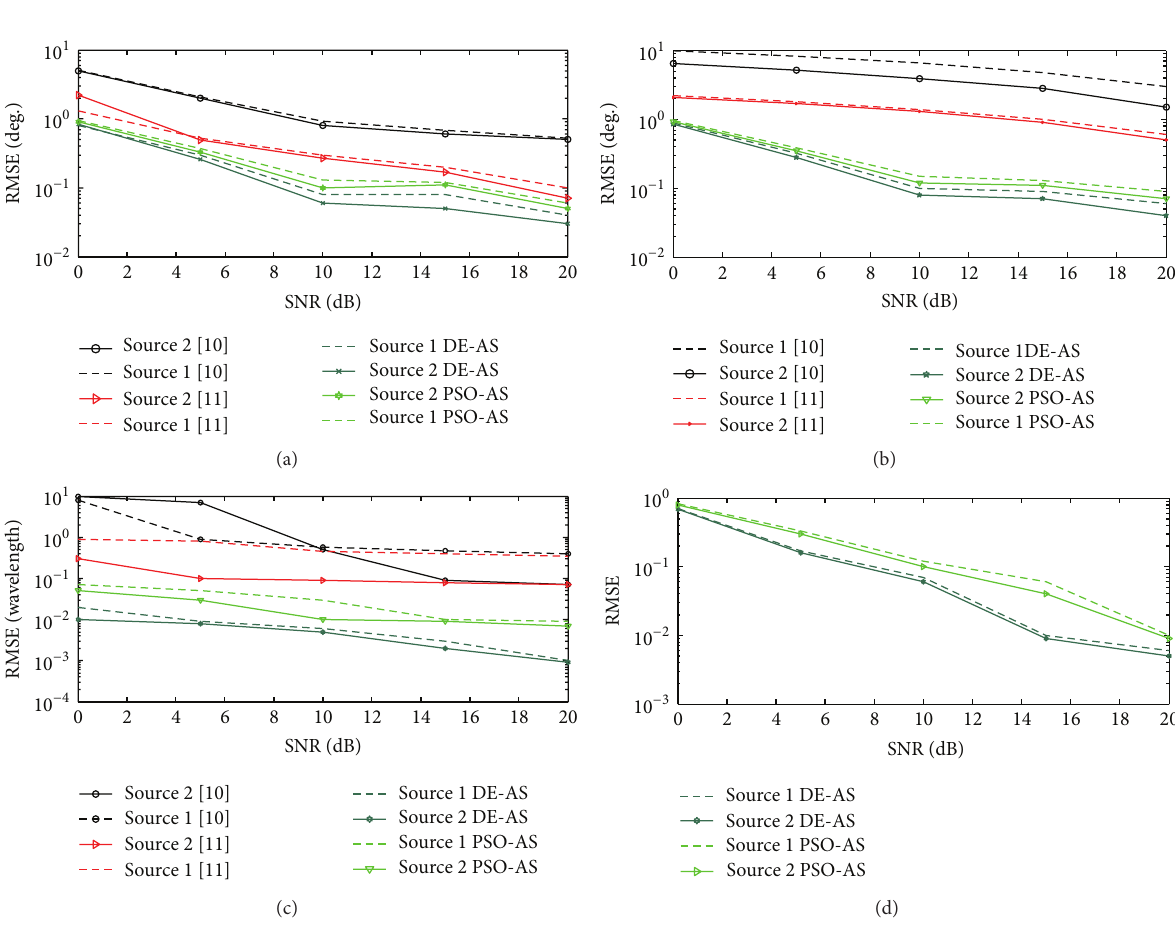
Figure 7: (a) Root mean square error of elevation angles versus SNR. (b) Root mean square error of azimuth angles versus SNR. (c) Root mean square error of ranges versus SNR. (d) Root mean square error of amplitudes versus